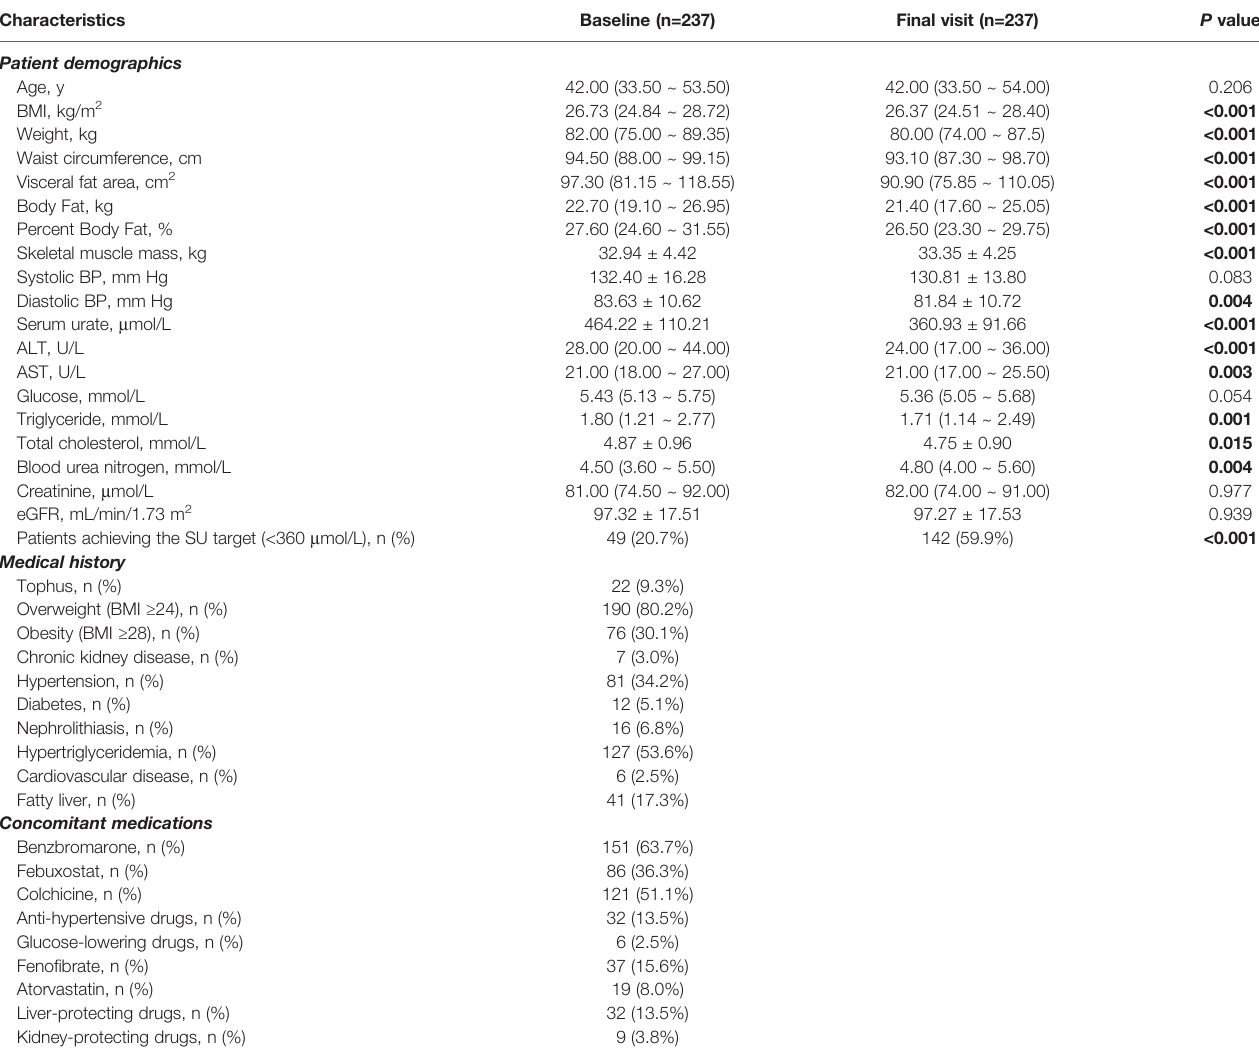
TABLE 1 | Main clinical characteristics of study patients at baseline and post ULT.